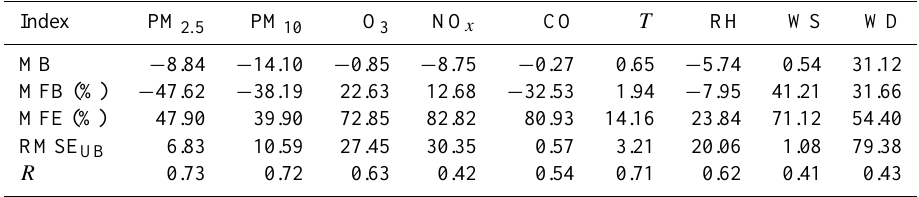
Table 5. Performance statistics for WRF-Chem predictions at all sites ∗ .